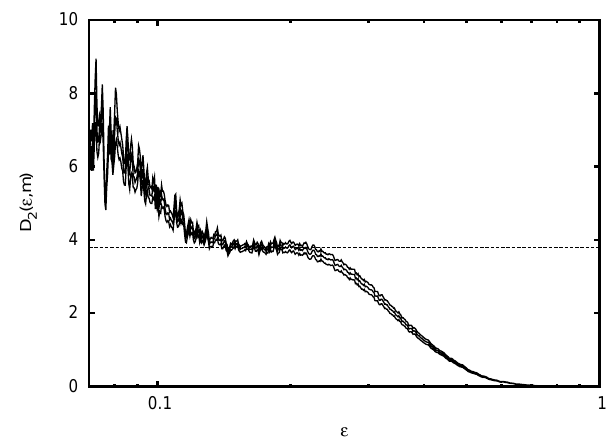
Fig. 9. The local slopes D 2 ((cid:15),m) for the detrended time series for m ranging from 14 to 16 with τ = 1 ,ω = 25 giving a plateau for small values of (cid:15) and giving an estimate of D 2 = 3 . 7967 ± 0 . 0116. The convergence of the plateau for higher dimensions is also evident in Fig. 11a indicating evidence of low